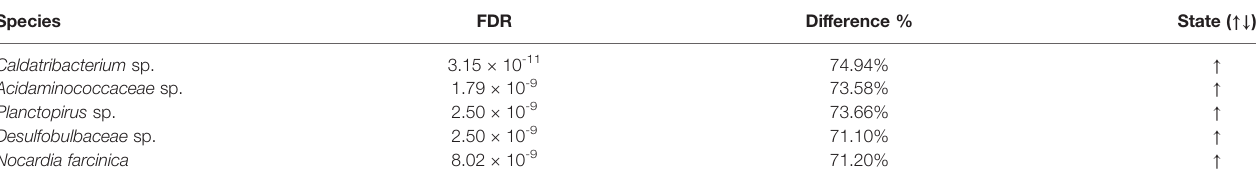
TABLE 3 | Bacteria with signi fi cant variability between normal and primary tumor tissues. Species FDR Difference % State ( ↑↓ ) Caldatribacterium sp. Acidaminococcaceae sp. Planctopirus sp.